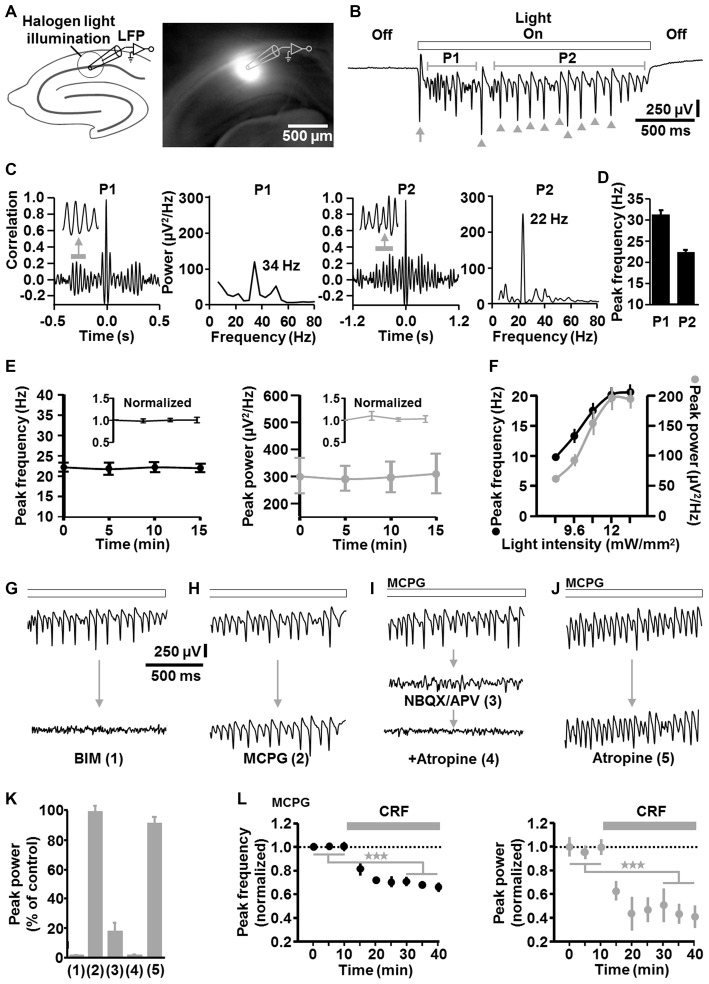
Descriptive properties and pharmacological characteristics of optogenetically induced fast CA1 network oscillations in brain slices from NEX-Cre-ChR2 mice. (A) Experimental setting and photograph illustrating the illumination of a circular portion of area CA1 with halogen light (12 mW/mm2). (B) Representative recording trace depicting the oscillatory network activity during ChR2 activation (arrow and arrow heads mark(s) clearly visible initial and subsequent population spike(s) generated by CA1 pyramidal neurons; P1, period 1; P2, period 2). (C) Autocorrelograms and power spectra for P1 and P2 of the rhythmic network activity shown in (B). (D) Average data from spectral analyses (n = 14 from 7 animals). (E) The peak frequency and peak power of the CA1 oscillations remained stable over repeated evocations (n = 8 from 4 animals). (F) Relationship between halogen light intensity and peak frequency/peak power of the CA1 oscillations (n = 8 from 6 animals). Light intensities above 12 mW/mm2 did not further increase both parameters of the oscillations. Note the increase of the frequency with increasing spectral power, which is typical for P-I oscillations. (G–K) Impact of the GABAA receptor antagonist bicuculline methiodide (BIM; n = 7 from 5 animals), the group I/II mGlu receptor blocker methylenecyclopropylglycine (MCPG; n = 3 from 3 animals), the ionotropic glutamate receptor antagonists NBQX and APV (n = 5 from 4 animals), and the mACh receptor blocker atropine (n = 4 from 3 animals for atropine alone) on the light-induced oscillations (all receptor blockers were administered at well proven maximal antagonizing concentrations). For each pharmacological condition, recordings were made 10 min after addition of the drug(s) to the extracellular solution and representative recording traces are shown in (G–J). Quantifications of the pharmacological effects are graphed in (K), with numbers 1–5 corresponding to the numbers in brackets in (G–J). (I,J) Extracellular solution contained MCPG. (L) Corticotropin-releasing factor (CRF) impaired the light-evoked CA1 oscillations. After recording a stable baseline, human/rat CRF was bath applied at 125 nM to slices. This treatment led to a marked decrease in the peak frequency and peak power of the oscillations (n = 7 from 4 animals, ★★★p < 0.001, one-sample t test). Extracellular solution contained MCPG.